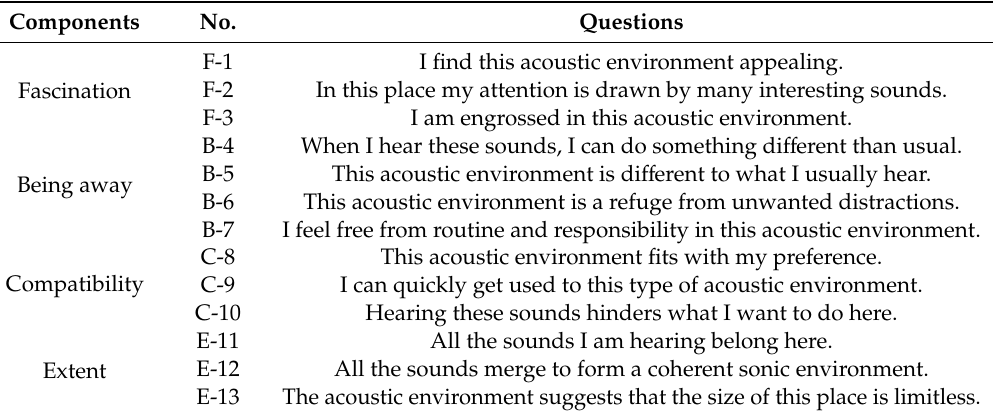
Table 3. Perceived restorativeness soundscape scale